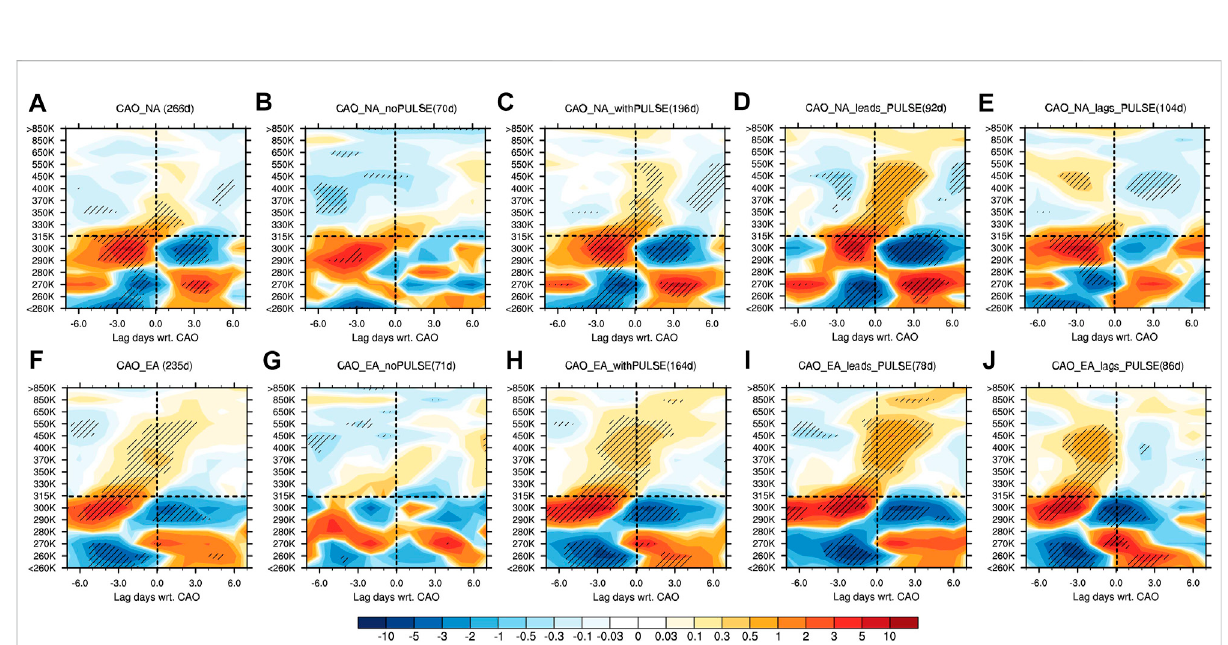
FIGURE 5 Meridional mass fl ux anomalies for latitudinal integration at 60 ° N at various isentropic layers at lag times from − 7 to 7 days relative to the peak daysof (A) allCAO_NAevents, (B) CAO_NAsthataredecoupledwithPULSEevents, (C) CAO_NAsthatarecoupledwithPULSEevents, (D) CAO_NAs that are lead-coupled with PULSEs, and (E) CAO_NAs that are lag-coupled with PULSEs. (F – J) are as (A – E) but for CAO_EA events. Slashed areas denote the composites statistically signi fi cant above the 95% con fi dence level using two-sided Student ’ s t test. The horizontal dashed line roughly marks the tropopause level, which is about 315